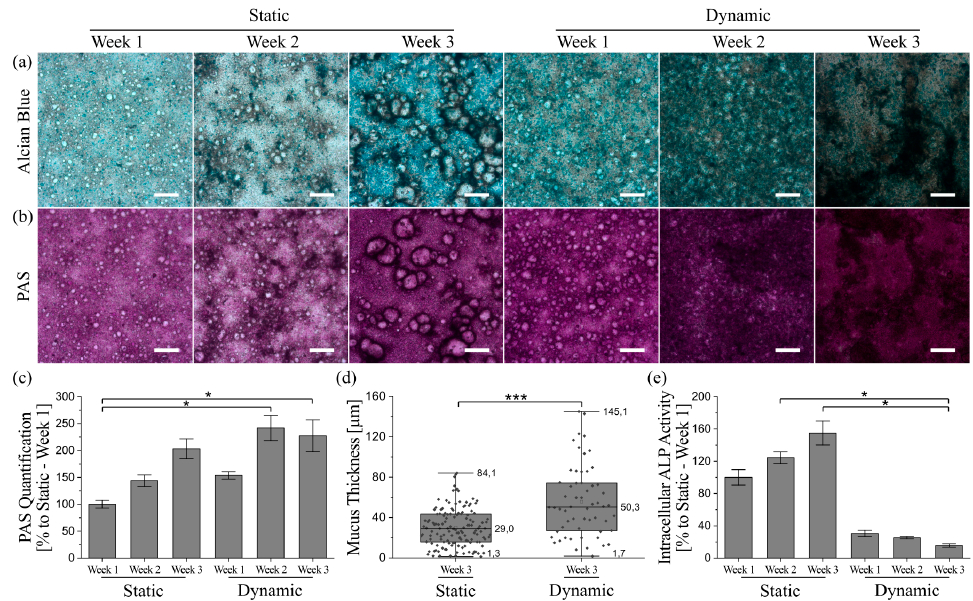
Figure 4. Qualitative and quantitative characterization of mucus produced by HT29-MTX cells under static and dynamic culture conditions at various time points. Microscopy images of ( a ) Alcian blue and ( b ) PAS-stained cells showing acidic mucins in blue and neutral mucins in purple, respectively. (Scale bars: 200 µm). ( c ) Photometrically quantified amounts of neutral mucins after PAS-incubation. Data presented as mean ± SEM with respect to week 1 under static conditions ( n = 3–5). ( d ) Adherent mucus layer thickness determined under native conditions via confocal imaging data, shown as box plot, including data points, median and full range ( n = 5). ( e ) Intracellular activity of ALP as enterocyte marker. Data presented as mean ± SEM with respect to week 1 under static conditions ( n = 3–8). Statistical significance indicated by * p ≤ 0.05 and *** p ≤ 0.0005.